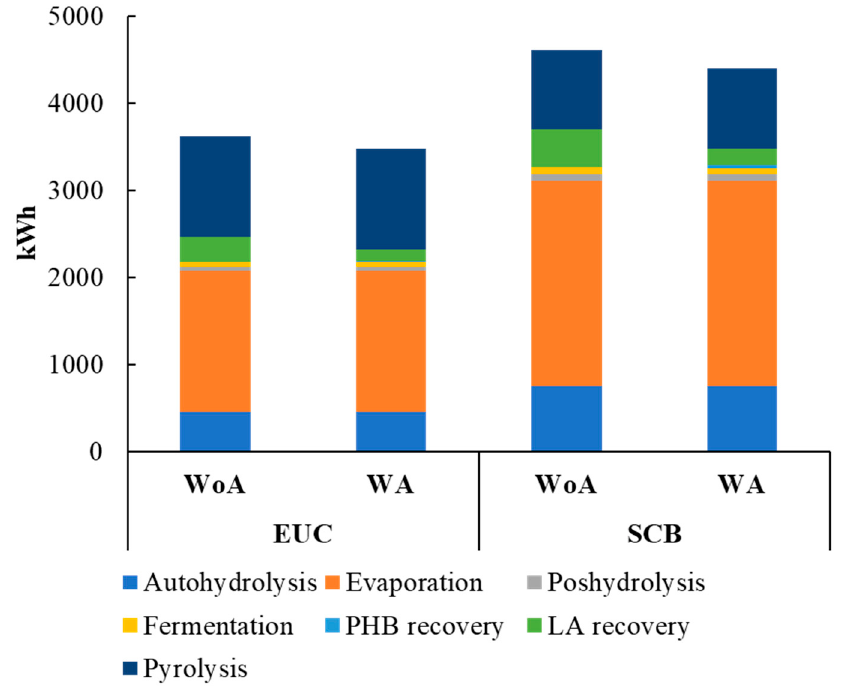
Figure 5. Energy consumption for each assessed scenario is based on dry tons of biomass. WA: with acetate. WoA: without acetate.